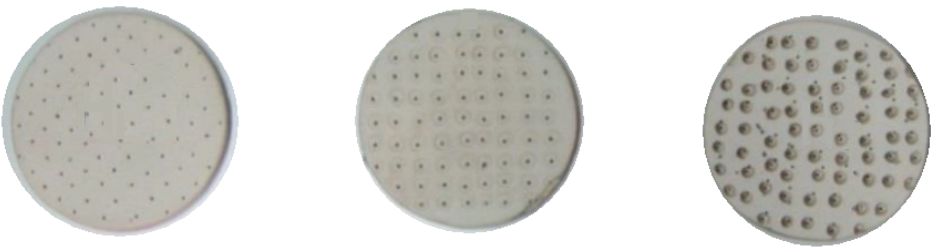
Figure 1. Specimens in ceramic material, with different thicknesses and percentages of perforation.